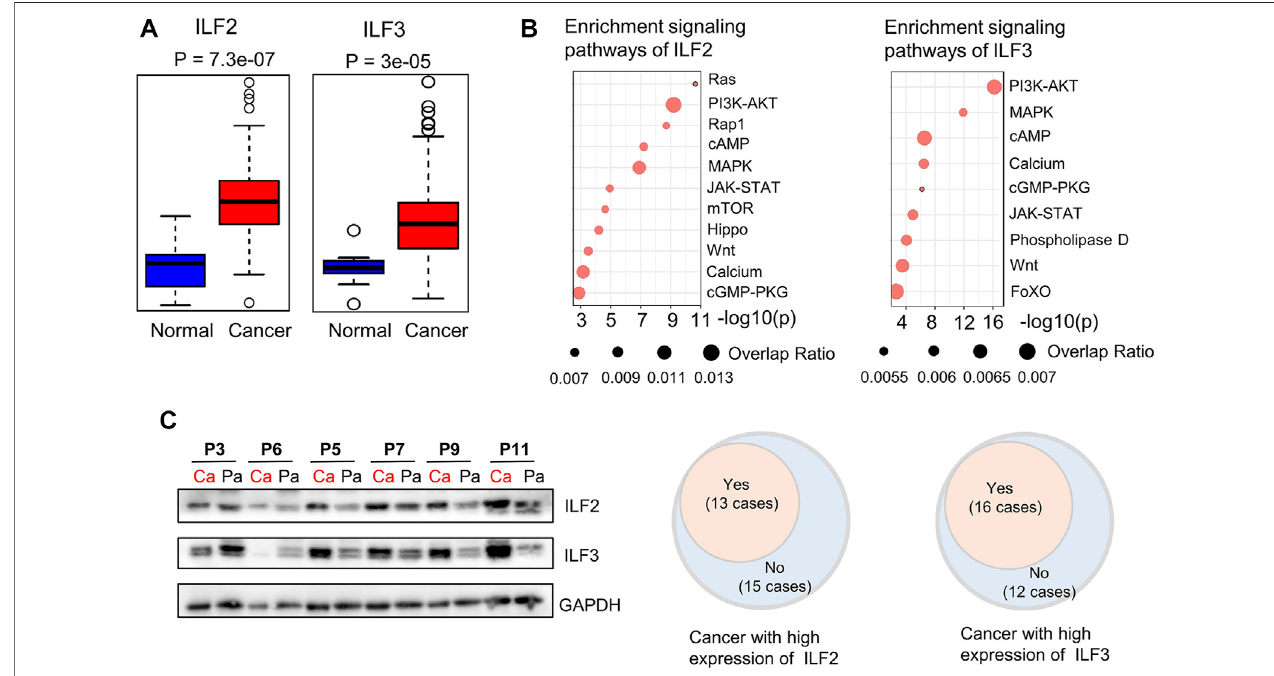
FIGURE4| BioinformaticanalysisofILF2andILF3relatedwithESCCandWesternblotanalysisofILF2andILF3in28cases. (A) .Gene-expressionanalysisofILF2 and ILF3 inEC accordingtopublic databases[n(cancer) (cid:2) 182;n (normal) (cid:2) 286]. (B) . Prediction ofsignaling pathways possibly affectedbyILF2 and ILF3in ESCC. (C) . Western blot analysis of ILF2 and ILF3 expression in 28 ESCC cases. GAPDH was used as aloading control in shown Western blot strips of representative 6 cases. (Ca indicated cancer tissues; Pa indicated para-cancer tissues.)